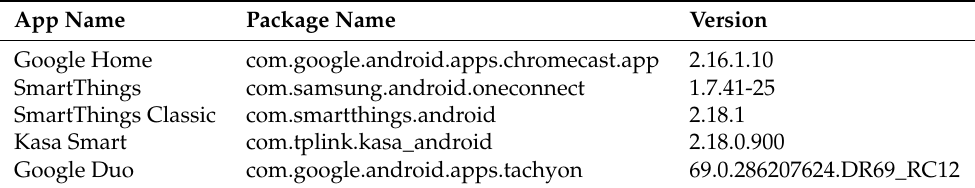
Table 4. Companion apps for smart home